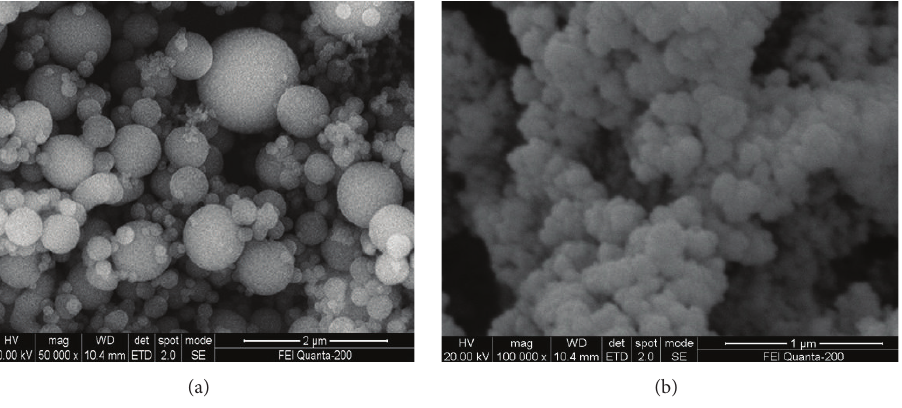
Figure 1: SEM photographs of SF (a) and NS (b).